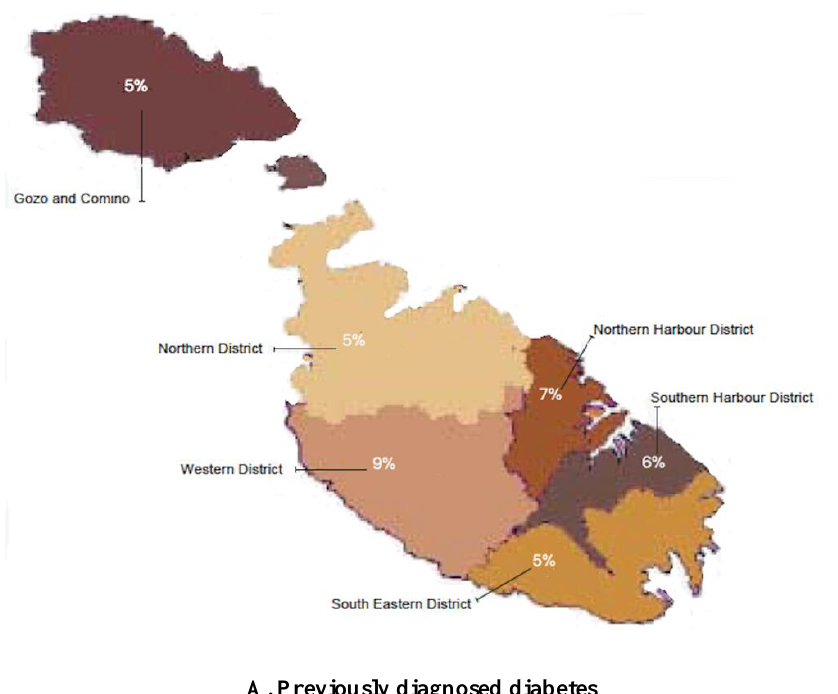
Figure 4. Previously diagnosed and newly diagnosed prevalence rates by